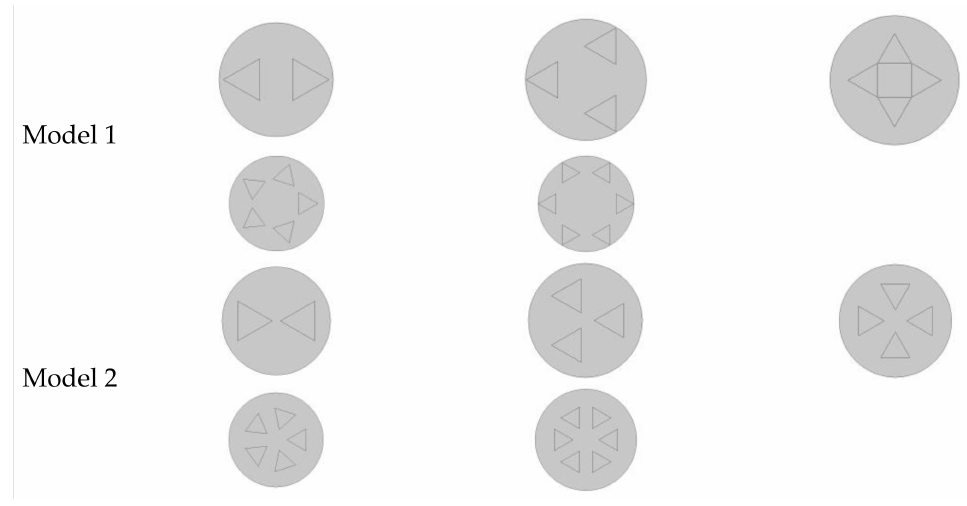
Figure 2. The models 1 and 2 with N = 2~6.